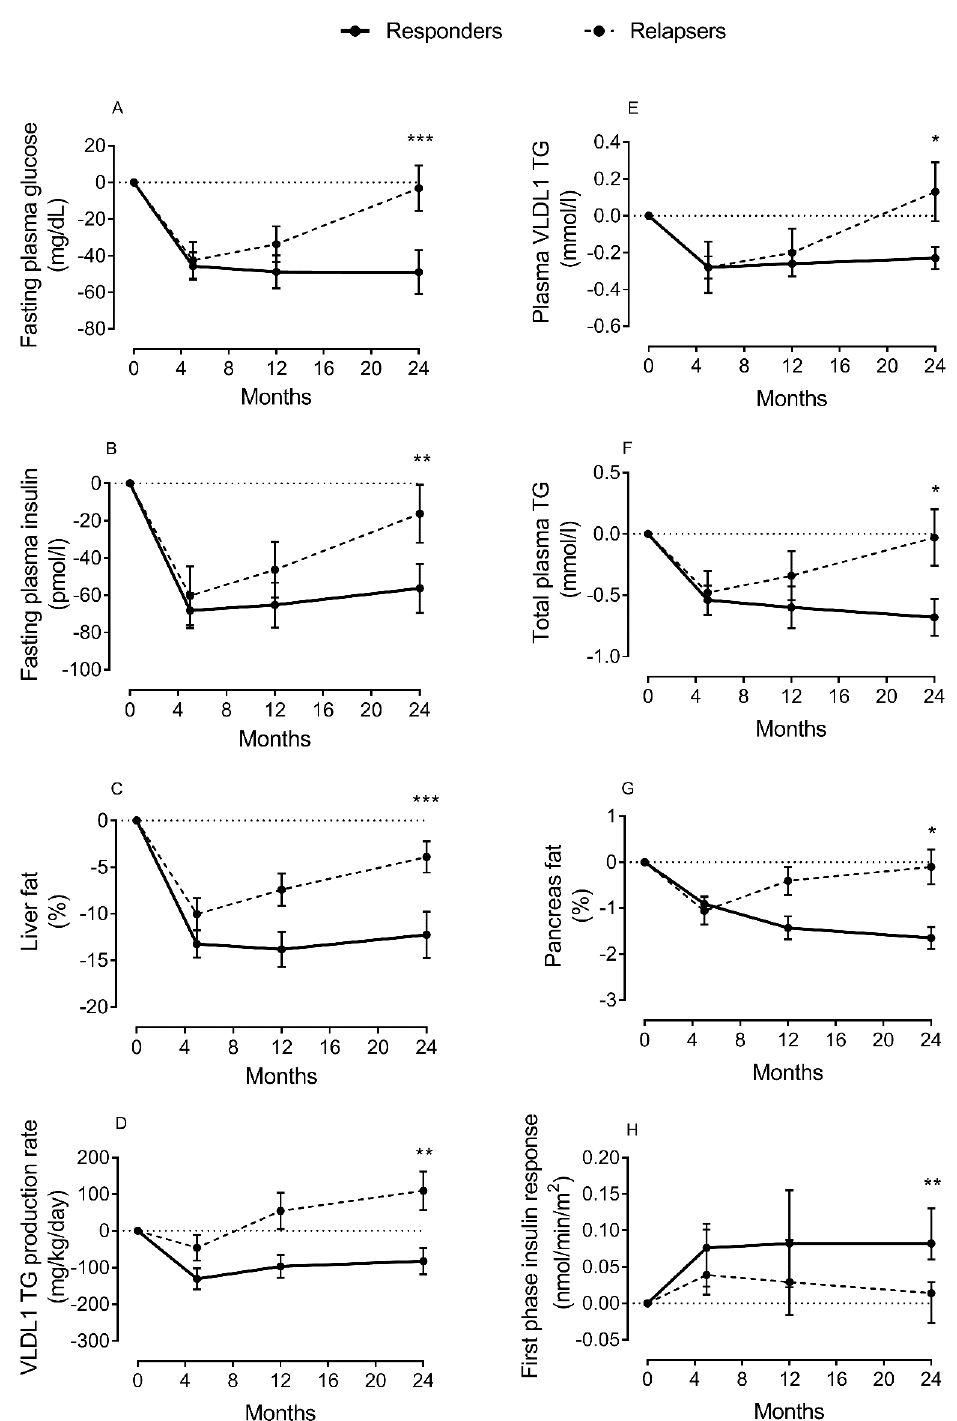
Figure 2. Change in lipid parameters and β -cell function during remission and relapse of type 2 diabetes. Change from baseline in fasting plasma glucose ( A ), fasting plasma insulin ( B ), liver fat ( C ), hepatic VLDL1-TG production ( D ), fasting plasma VLDL1-TG ( E ), total plasma triglycerides (TGs) ( F ), intrapancreatic fat ( G ), and β -cell function ( H ) at 5 months (responders n = 38; relapsers n = 13), 12 months ( n = 28/ n = 13, respectively), and 24 months ( n = 20/ n = 13, respectively). Responders are presented as a solid black line and relapsers as a dashed line. The dotted line is the gridline at y value = 0. Paired data between baseline and each time point are presented. Data are presented as mean ± SEM except for first-phase insulin (median with IQ range) vs. 5 months in relapsers: * p < 0.05, ** p < 0.01, *** p < 0.001. Figure is presented with permission [43].